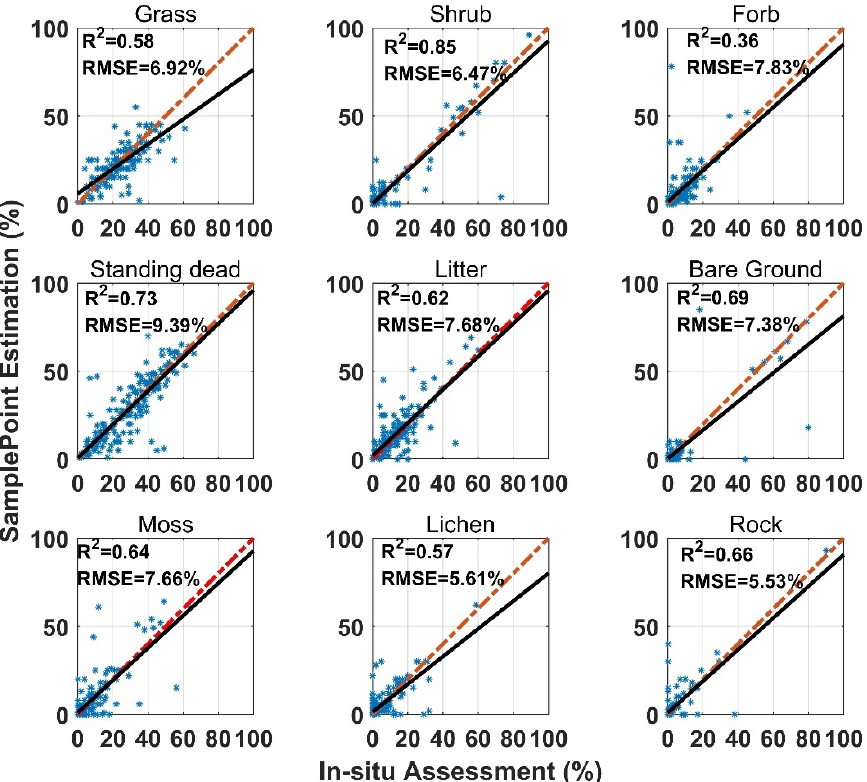
Figure 3. Comparison of in situ assessment and SamplePoint estimation for nine FVC categories (red dashed line is the 1:1 relationship; dark solid line is the linear regression). The regression significance level ( p -value) is 0.01.